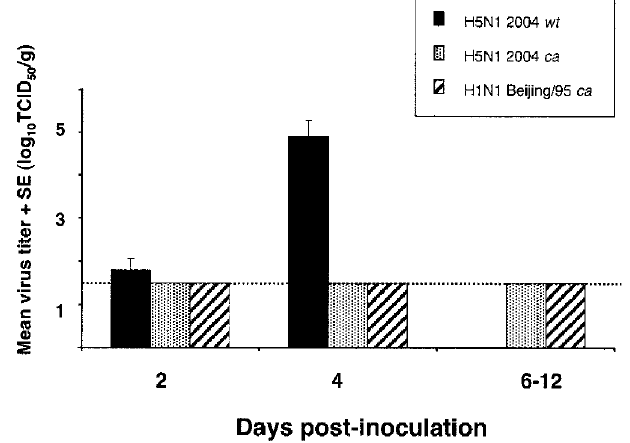
Figure 1. Replication of H5N1 2004 ca and 2004 wt Viruses in the Brains of Mice The H5N1 2004 ca virus, unlike the H5N1 2004 wt parent virus, is undetectable in the brain. Influenza A/Beijing/95 ca, an H1N1 ca reassortant virus, was also undetectable in the brains of mice. The lower limit of detection is indicated by the dashed horizontal line. Four mice per group were euthanized at each time point (days 2, 4, 6, 8, 10, and 12). Data from days 6 through 12 are combined in the figure because virus was not detected in any of the brain tissues harvested on these days. DOI: